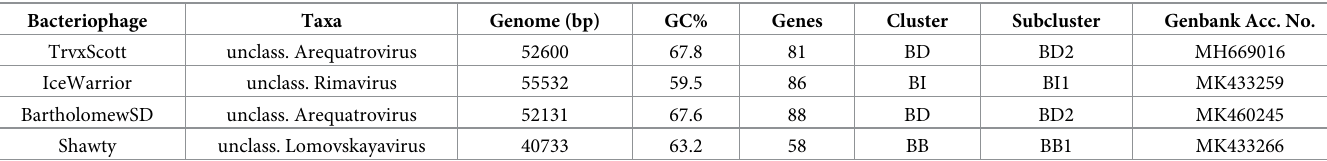
Table 7. Summary of the NCBI WGS annotations of four phage